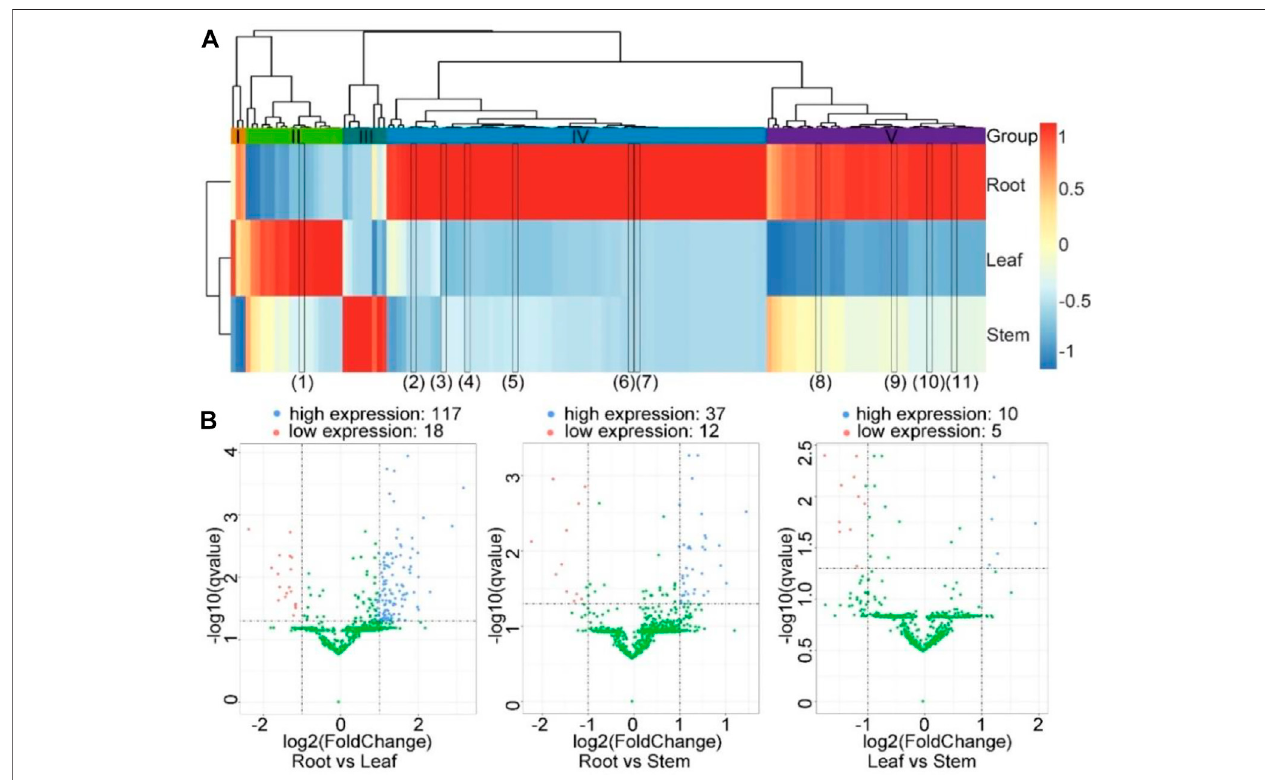
FIGURE5| DifferentialexpressionofcircRNAsamongthethreetissues. (A) Theheatmapshowedtheexpressionpro fi lesofthecircRNAsacrossthreetissues.The color corresponds to the Z-score transformed from the RPM values of circRNAs in the corresponding tissue types. The color panel is shown on the right. The tissues were clustered in the horizontal direction, while the circRNAs were clustered in the vertical direction. Five clusters of circRNAs, I, II, III, IV, and V, are shown between the hierarchical tree and heatmap. The black rectangles in the heatmap represent the validated circRNAs that were differentially expressed among the three tissues, from left to right: (1) SMscf5077-22608-23239, (2) SMscf2473-46693-46978, (3) SMscf4140-50187-50921, (4) SMscf1368-52664-53164, (5) SMscf16-111773- 112193, (6) SMscf550-26951-27637, (7) SMscf1271-41093-41414, (8) SMscf2943-49422-49697, (9) SMscf2773-28597-28968, (10) SMscf354-48544-48880, (11) SMscf534-16776-17238. (B) The volcano plots showing the differential expressions of circRNAs between the root and leaf, root and stem, and leaf and stem samples. The X-axis isthe log2(foldchange), and the Y-axisis the − log 10 ( q value). The horizontal dashed lineindicates where the q value equals 0.05, and the verticaldashed line indicates where the fold change equals 1 or − 1, respectively. Those with a q value < 0.05 and log2(fold change) ≥ 1 were considered signi fi cantly highly expressed and represented by blue points. In contrast, those with a q value < 0.05 and log2(fold change) ≤ − 1 were considered signi fi cantly lowly expressed and represented by red points. TherestofthecircRNAs wereconsidered lesssigni fi cantlydifferentiallyexpressedand represented bygreenpoints.Thenumbersofsigni fi cantlyhighlyandlowly expressed genes in each comparison are shown above the corresponding volcano plots.